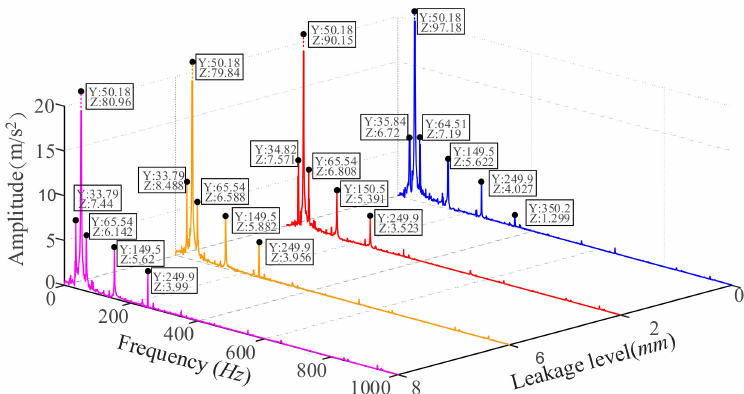
Figure 8. Frequency-domain waveform of RC current signals with di ff erent leakage